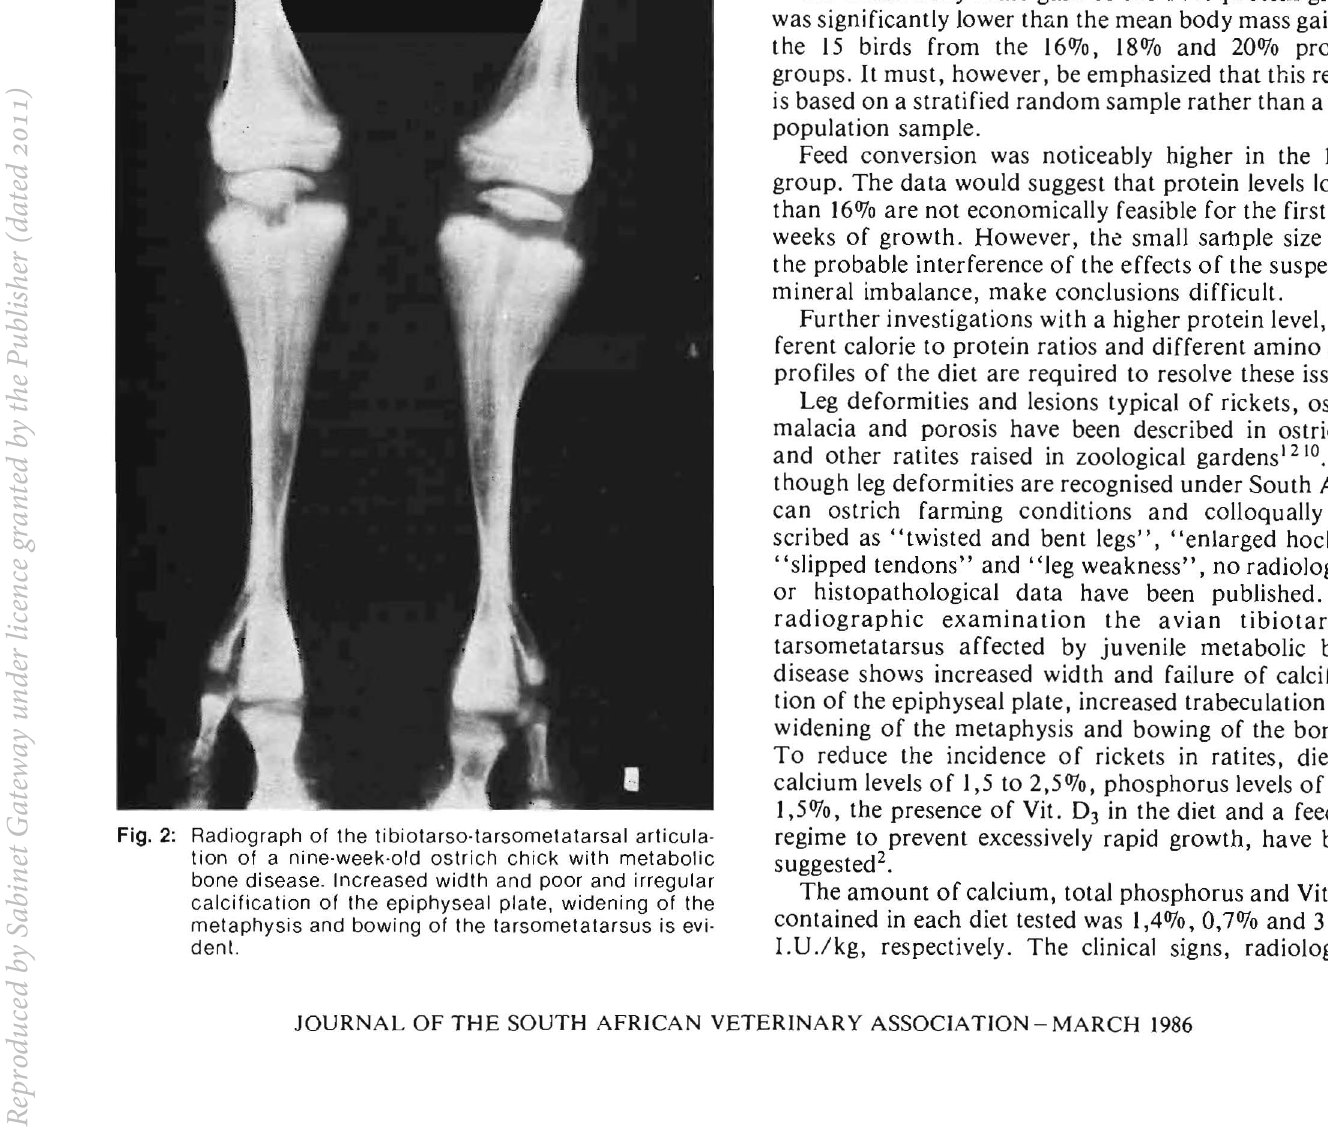
Fig. 2: Radiograph of the tibiotarso·tarsometatarsal articula· tion of a nine·week·old ostrich chick with metabolic bone disease. Increased width and poor and irregular calcification of the epiphyseal plate, widening of the metaphysis and bowing of the tarsometatarsus is evi·